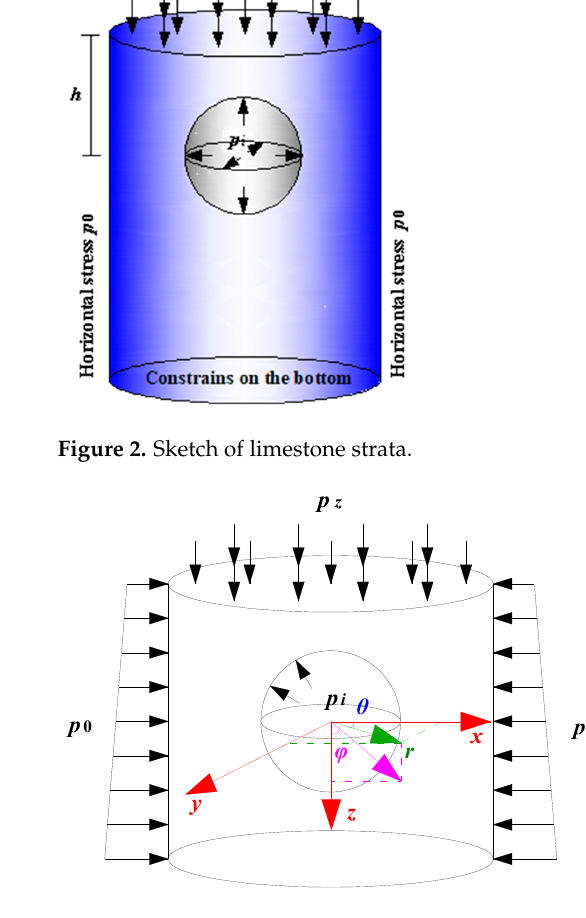
Figure 3. Mathematical model.